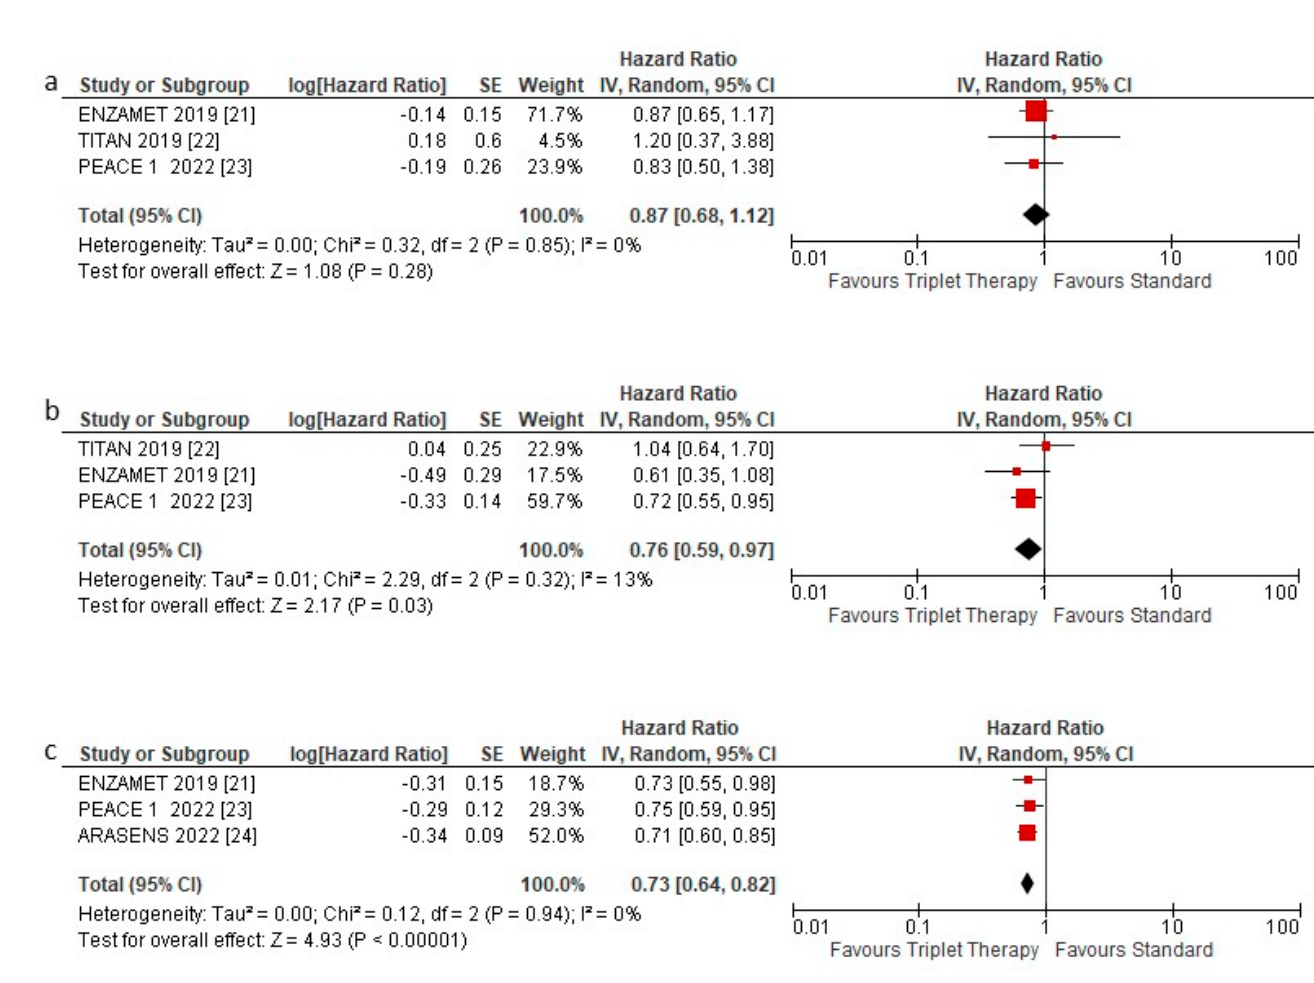
Figure 4. Forest plot of ( a ) overall survival hazard ratios in low volume patients, ( b ) overall survival hazard ratios in high-volume patients, and ( c ) overall survival hazard ratios in de novo patients included in the meta-analysis, obtained using a random model. Studies are arranged by publication year.